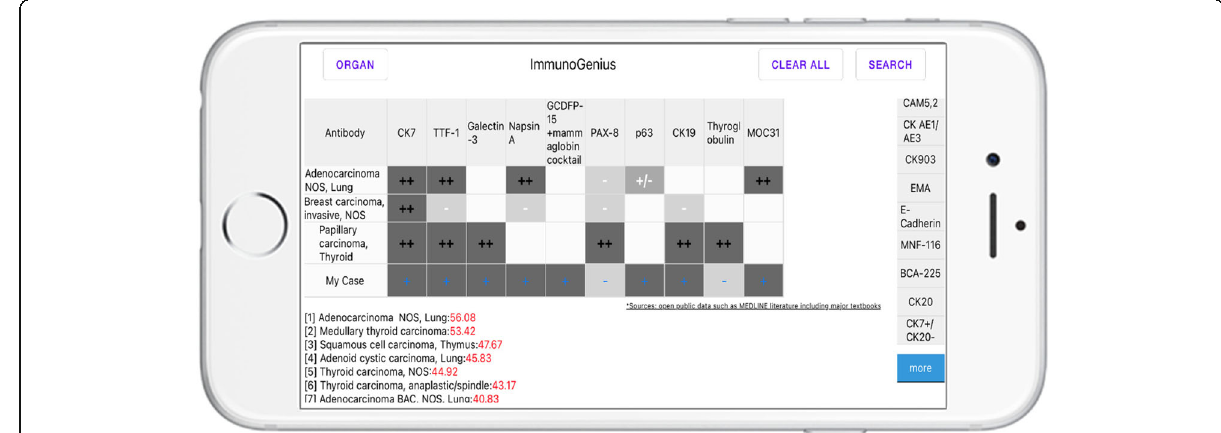
Fig. 3 The screenshot of the mobile application “ ImmunoGenius